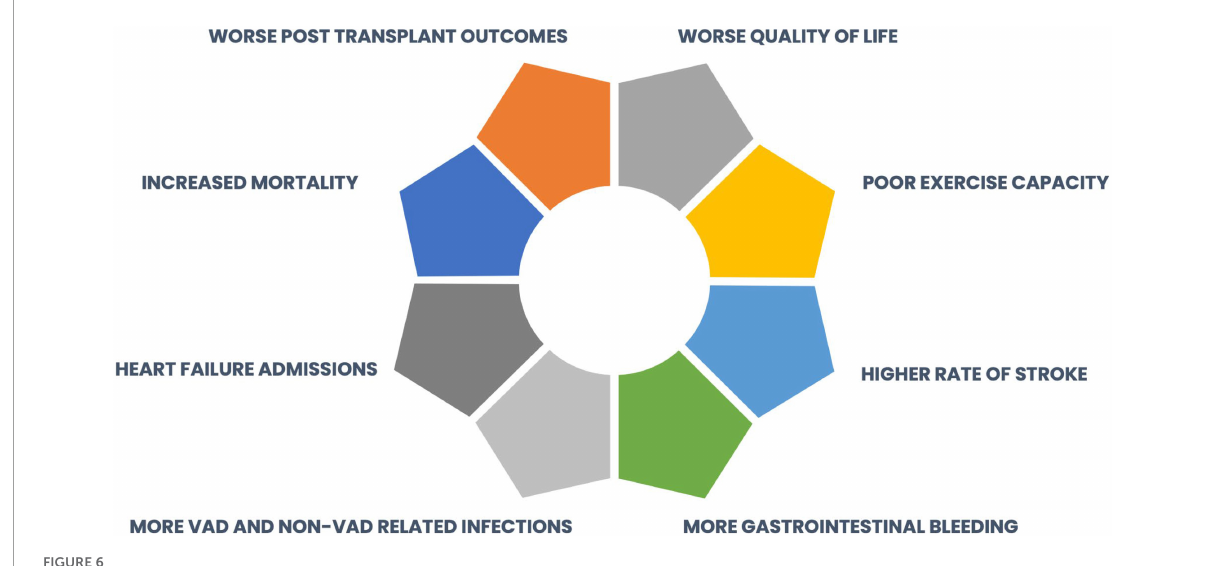
FIGURE6 Adverse events associated with right ventricular failure after LVAD